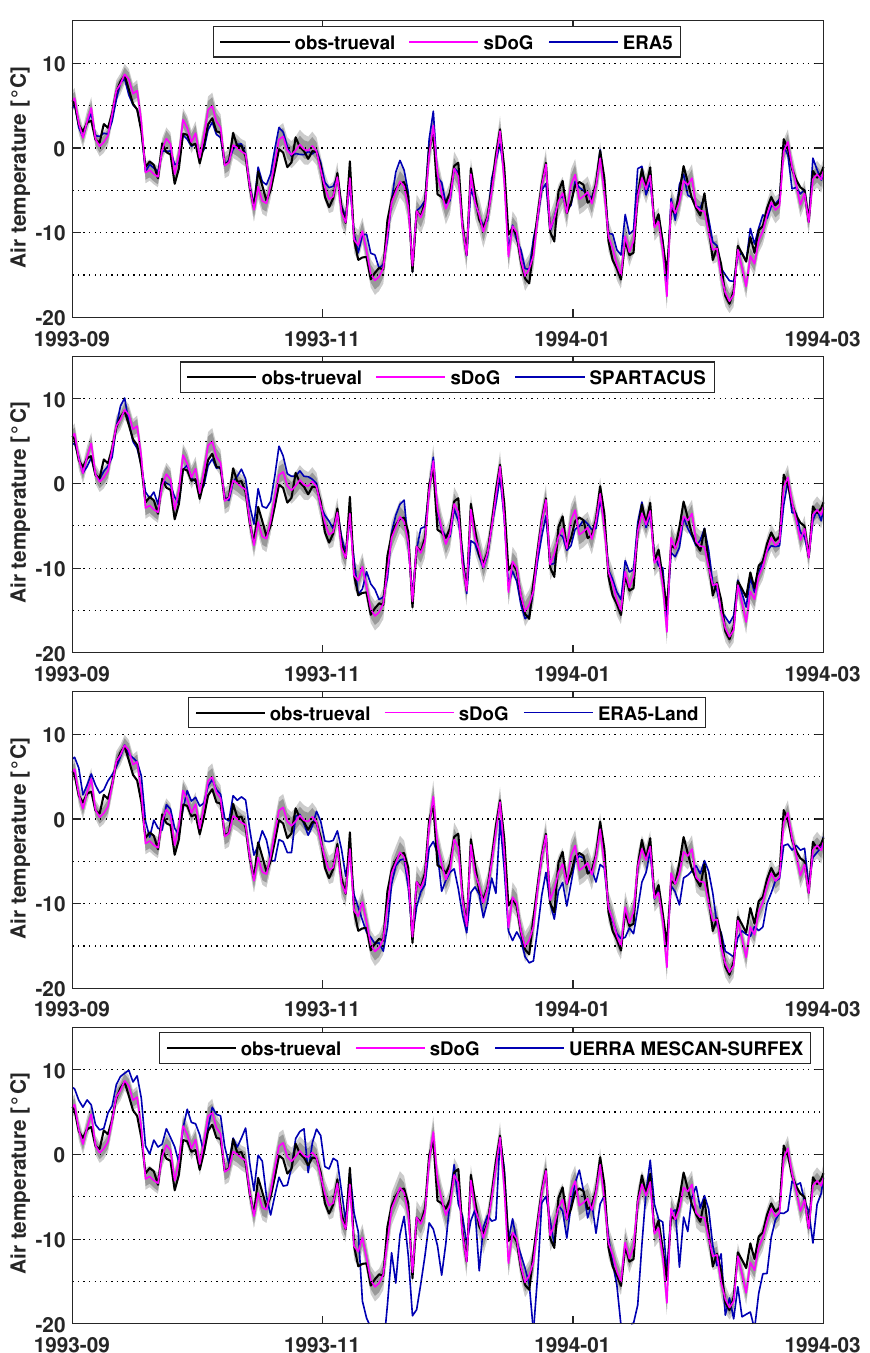
Figure 6. Daily air temperature at VERNAGT: observations (black), the sDoG retrospective forecast (magenta) along with uncertainties (1SE and 2SE, dark and light grey shadings), and the reference data sets ERA5, SPARTACUS, ERA5-Land and UERRA MESCAN-SURFEX (blue). Shown is an arbitrarily selected snapshot in the true evaluation